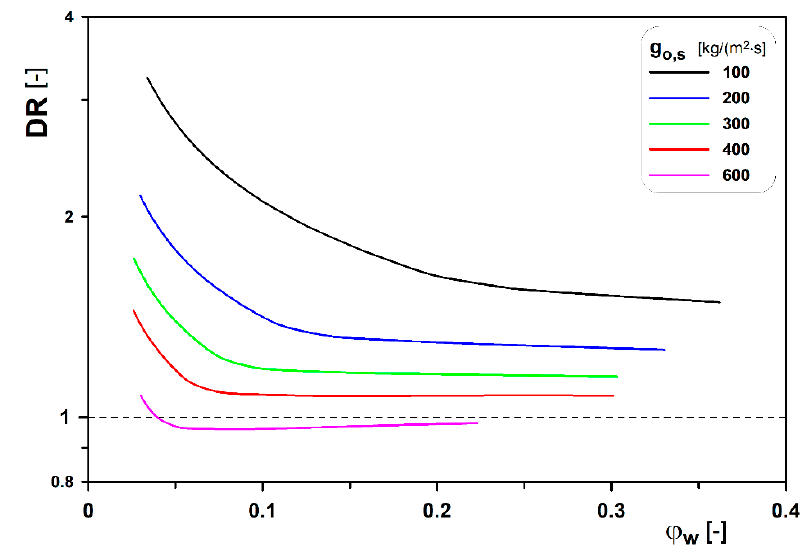
Figure 7. Variations in DR index for oil with the viscosity of η r =25.